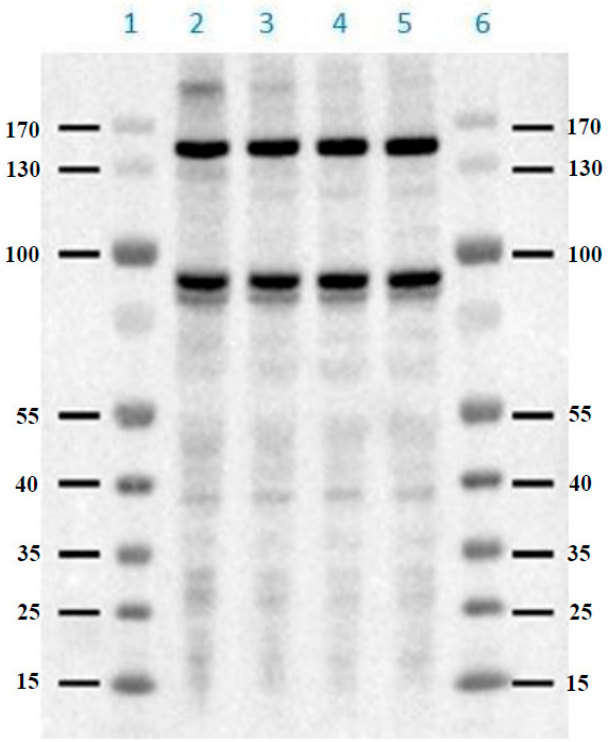
Figure 3. Results of SDS-PAGE analysis of photoaffinity labeling of experiment by synthesized probe 2d .